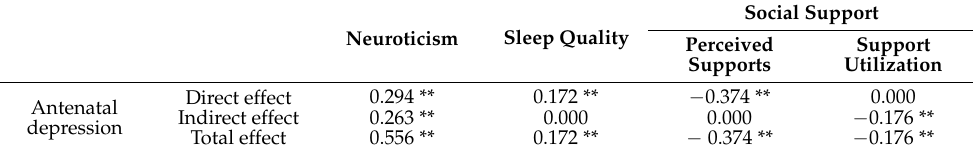
Table 3. Effects of neuroticism, social support, and sleep quality on antenatal depression ( n = 773). Neuroticism Sleep Quality